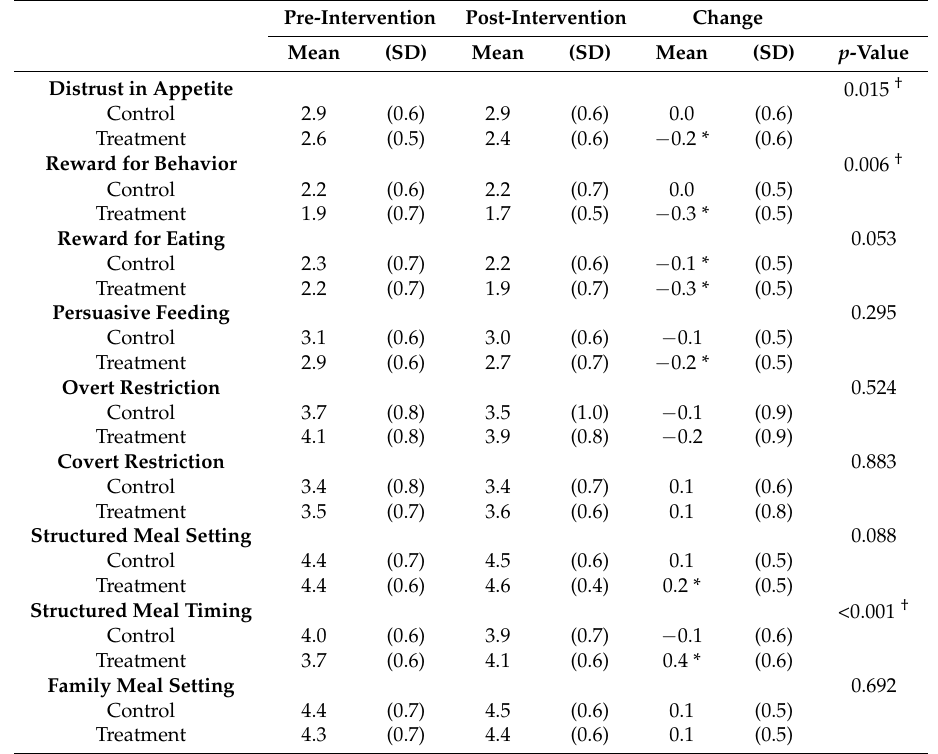
Table 3. Changes in feeding practices according to the Feeding Practices and Structure Questionnaire subscales among parents of children 2–5 years participating in a primary care pediatric weight management